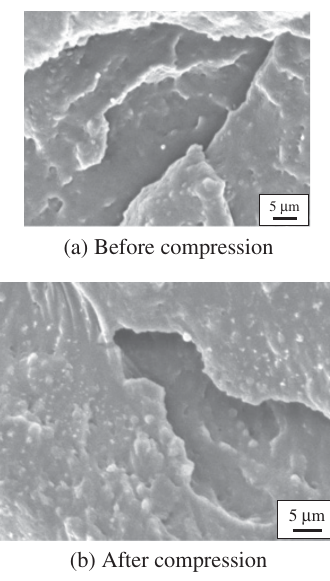
Fig. 14. Photographs of cryo-fractured surfaces taken using a scanning electron microscope; 1150 [1 / s] of Fig.